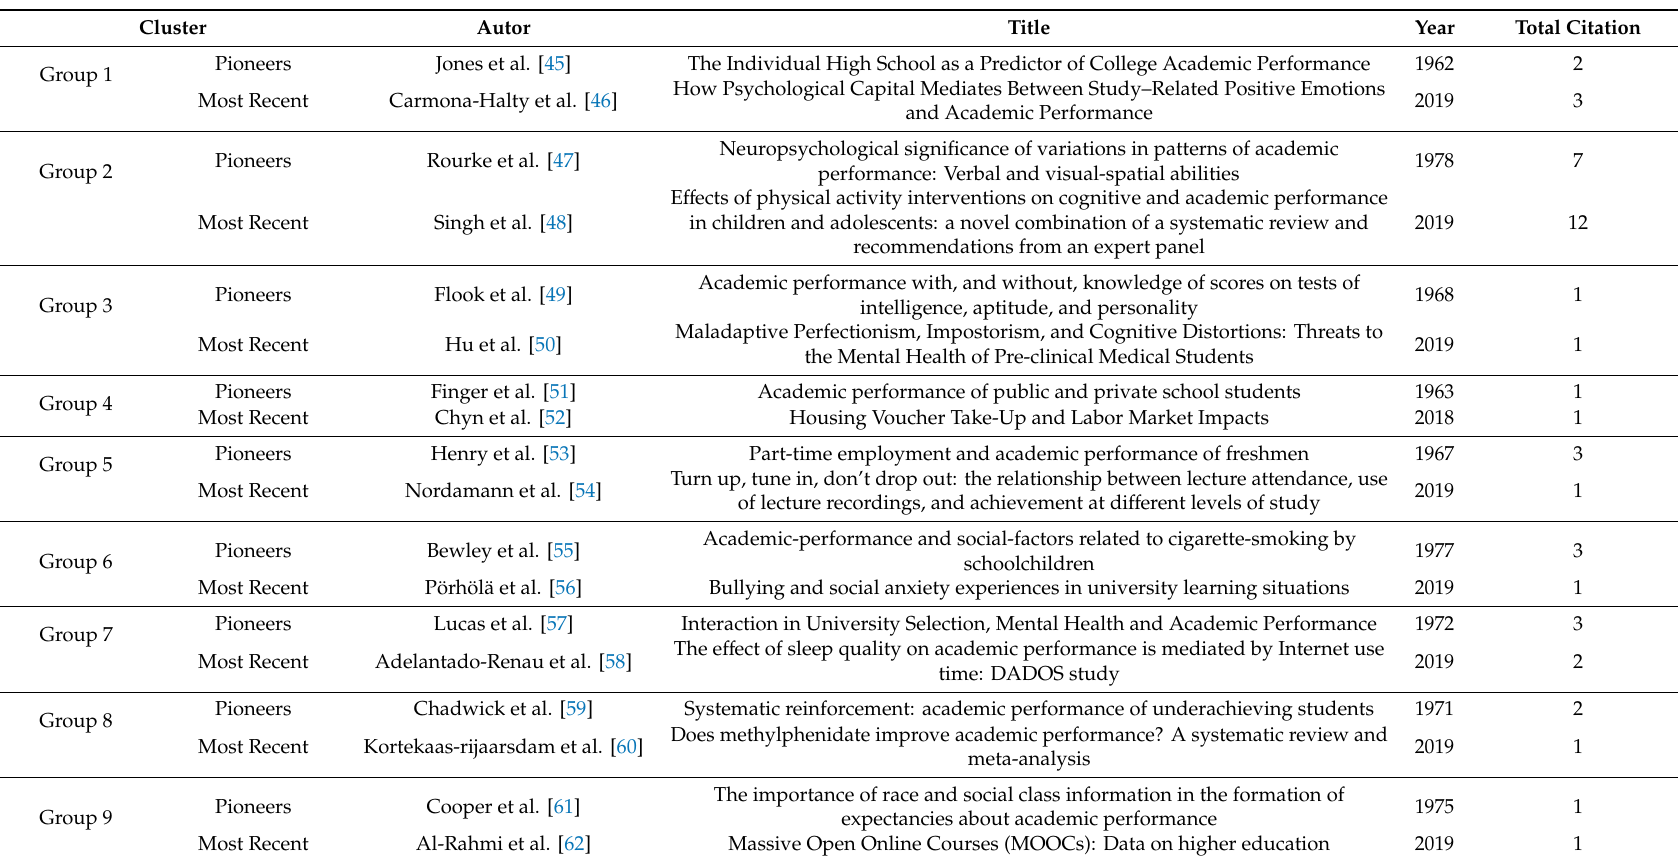
Table 3. The oldest and most recent journal information from the nine main